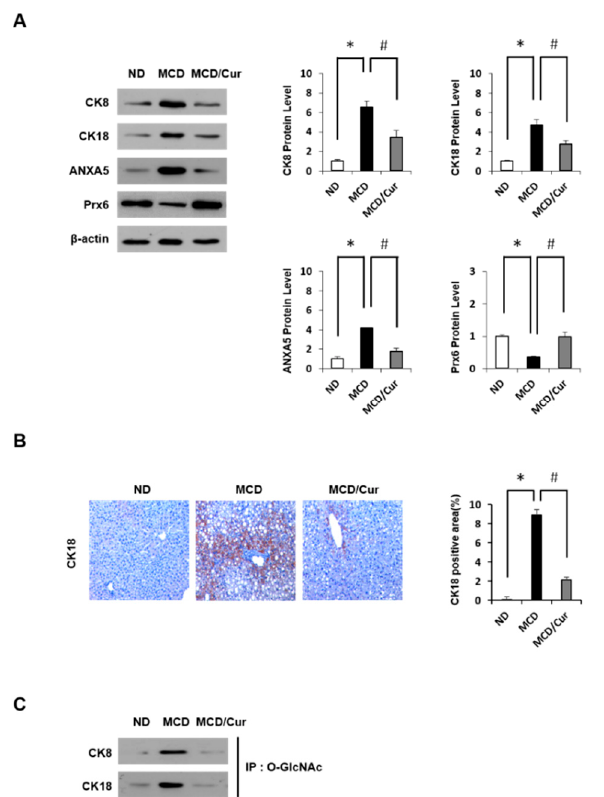
Figure 3. Verification of differentially expressed proteins. Liver tissue extractions were supplied from mice fed ND, MCD diet, or MCD/curcumin (100 mg/kg) diet. ( A ) The hepatic protein expression levels of Cytokeratin 8 (CK8), Cytokeratin 18 (CK18), AnnexinA5 (ANXA5) and peroxiredoxin 6 (Prx6) were determined by immunoblotting using equally identified amounts of total liver protein by immunoblotting. The levels of proteins were normalized to endogenous β -actin protein for each group. Data were obtained three times of independent experiments. ( B ) Liver sections were analyzed by the IHC test with antibody against CK18 (original magnification 200×). ( C ) O -GlcNAc ( O -linked β - N-acetylglucosamine) was immunoprecipitated with anti- O -GlcNAc antibody and then immunoblotted against CK8 and CK18, separately. Data are mean ± SD ( n = 7/group). * p < 0.05 vs. ND diet group, and # p < 0.05 vs MCD diet group.